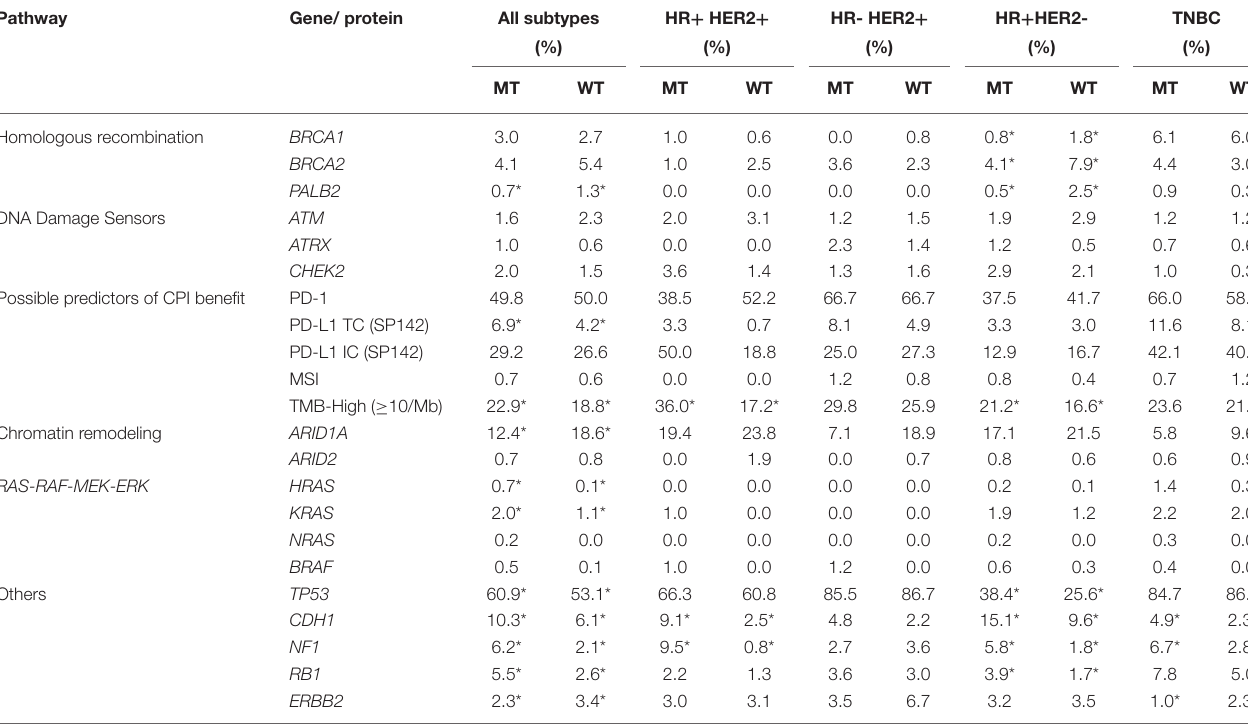
TABLE 3 | Selected co-alterations based on statistical significance. Pathway